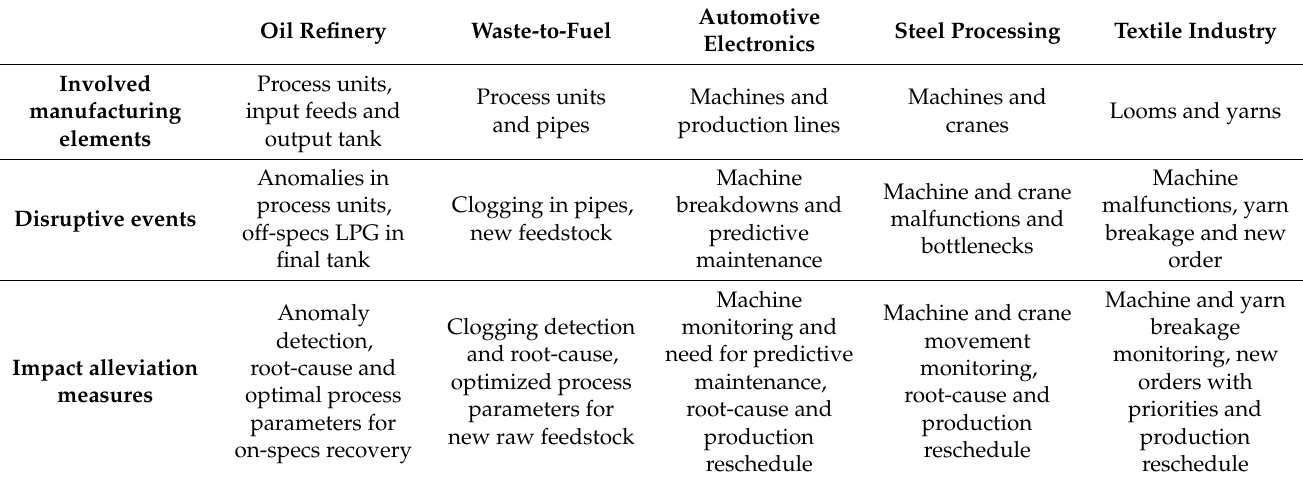
Table 1. Manufacturing elements, disruptive events and impact alleviation measures.